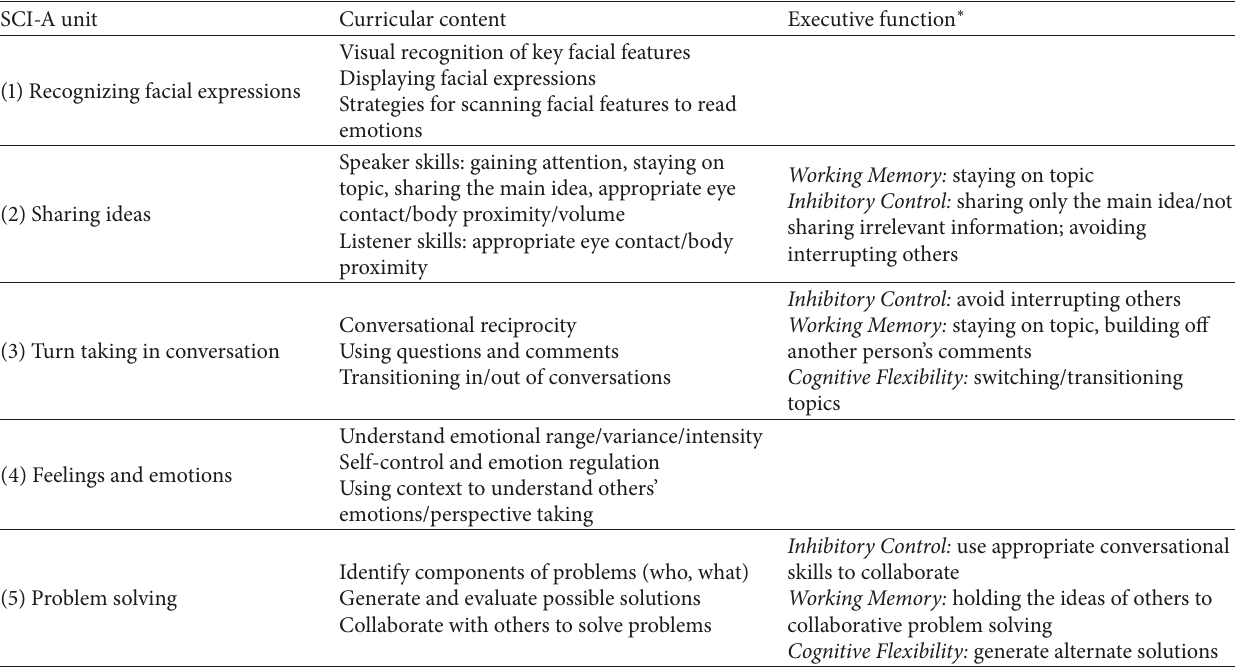
Table 2: Association of SCI-A curricular units and executive